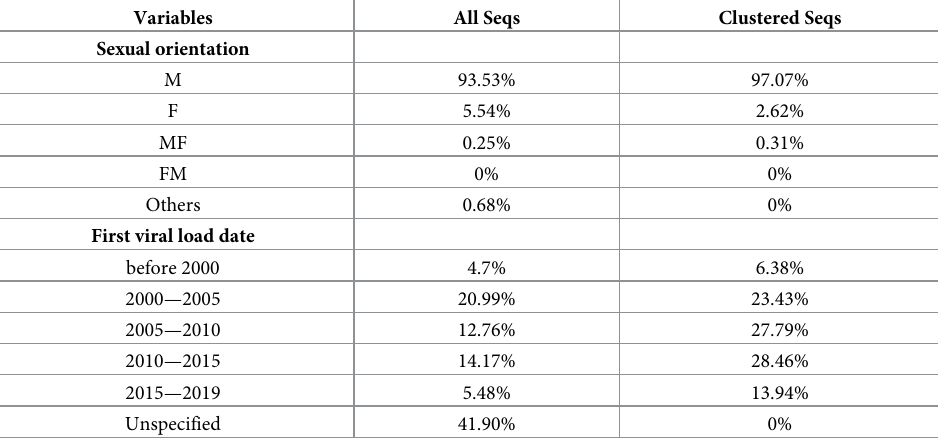
Table 1. San Diego PIRC (Primary Infection Resource Consortium) data: